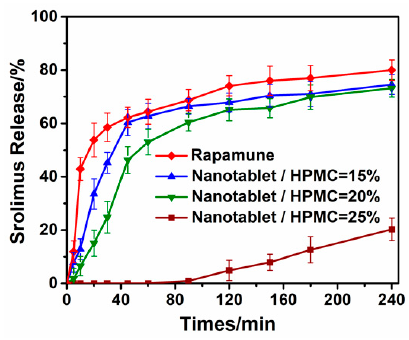
Figure 12. Effect of HPMC amount on dissolution of tablets.